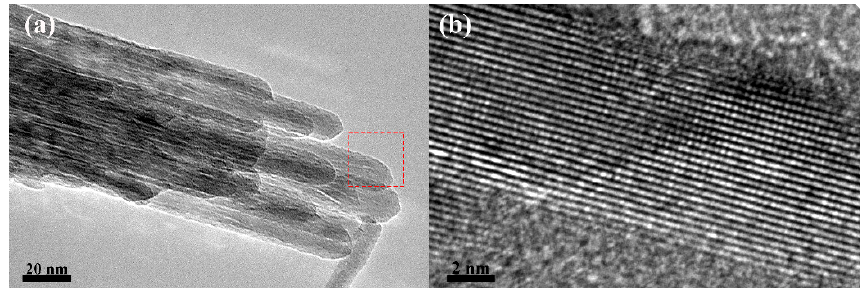
Figure 5. ( a ) Transmission electron microscopy (TEM) images and ( b ) High resolution transmission electron microscopy (HRTEM) image of Sn-doped TiO 2 NWAs (TS2).